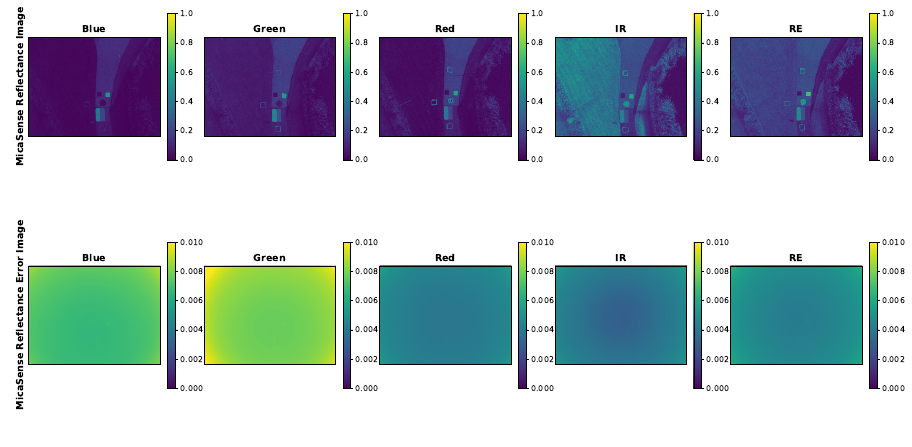
Figure 27. Example sUAS reflectance factor image and reflectance factor error image. Radiance image computed using MicaSense methodology and AARR used to compute reflectance factor. Reflectance factor error only contains gain, exposure time, image and DLS error. Error image is overwhelmed by the vignette shape. Reflectance factor is a unit-less